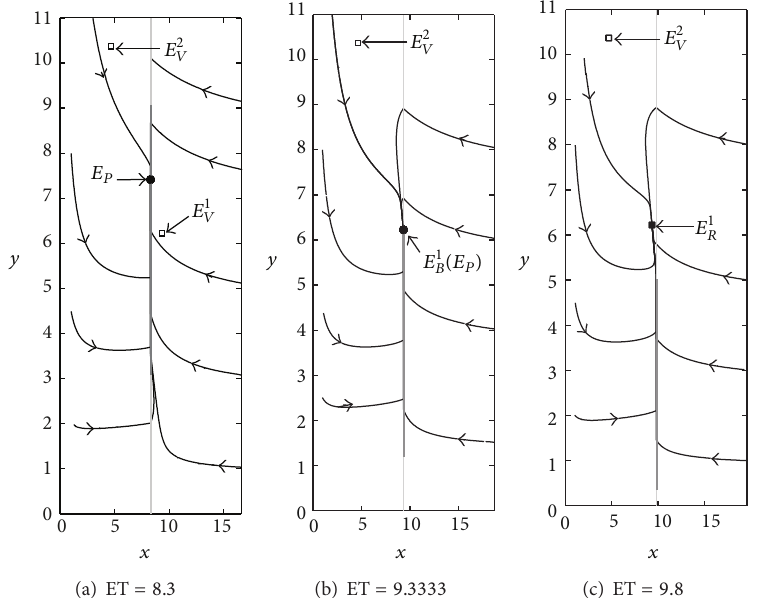
Figure 3: Boundary node bifurcation for Filippov system (3). The parameter values are fixed as follows: 𝑎 = 0.7 , 𝑏 = 0.6 , 𝑟 = 1.5 , 𝑘 = 12 , = 0.25 , and 𝑞 = 0.1 . 𝛽 = 0.5 , 𝛿 = 0.25 , 𝑞 1 2